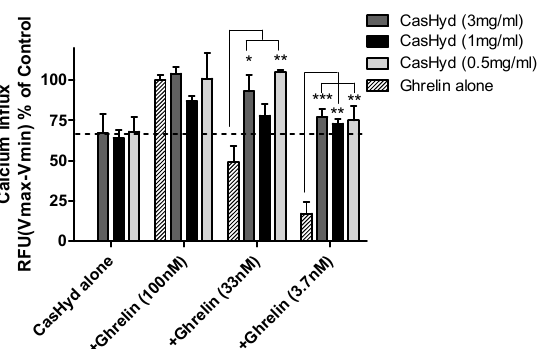
Figure 5. Additive GHS-R1a activation following co-treatment of ghrelin and CasHyd. Additive calcium mobilisation is observed following co-treatment of HEK cells stably expressing the GHS-R1a-eGFP with 33 nM of ghrelin and CasHyd. Graph represents the mean ± SEM of a representative experiment of three independent experiments. Each concentration reported was carried out in triplicate. Intracellular calcium increase was normalised to maximal calcium increase as elicited by control (100 nM ghrelin). Statistically significant differences were calculated using a one-way analysis of variance (ANOVA) followed by the Bonferroni post-hoc test for multiple comparisons and are depicted as *** p < 0.001, ** p < 0.01 and * p < 0.05.